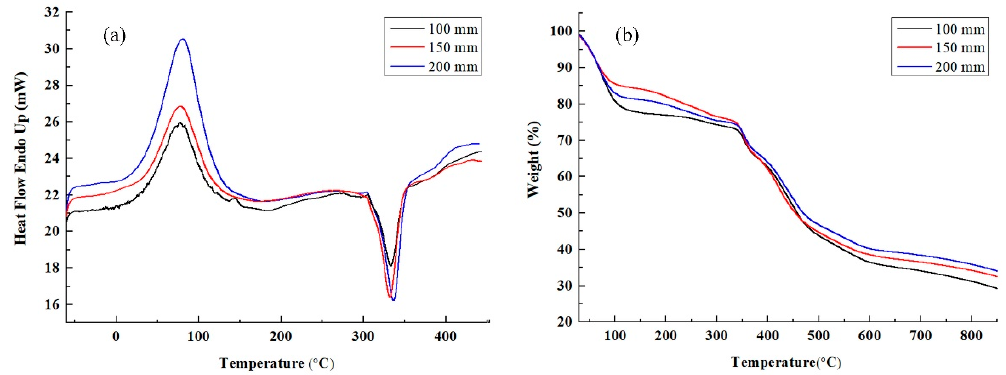
Figure 16. ( a ) DSC and ( b ) TGA curves of fiber membranes with different receiving distances.